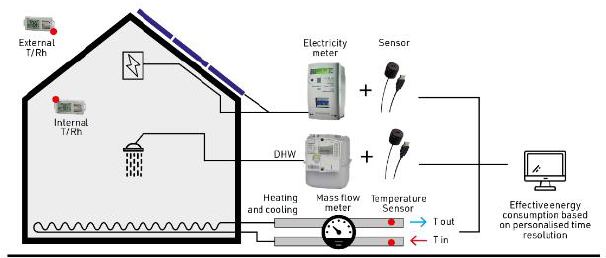
Figure 5. Advanced level: Configuration 5: dwelling with centralized heating and cooling systems. Source: elaborated by authors.